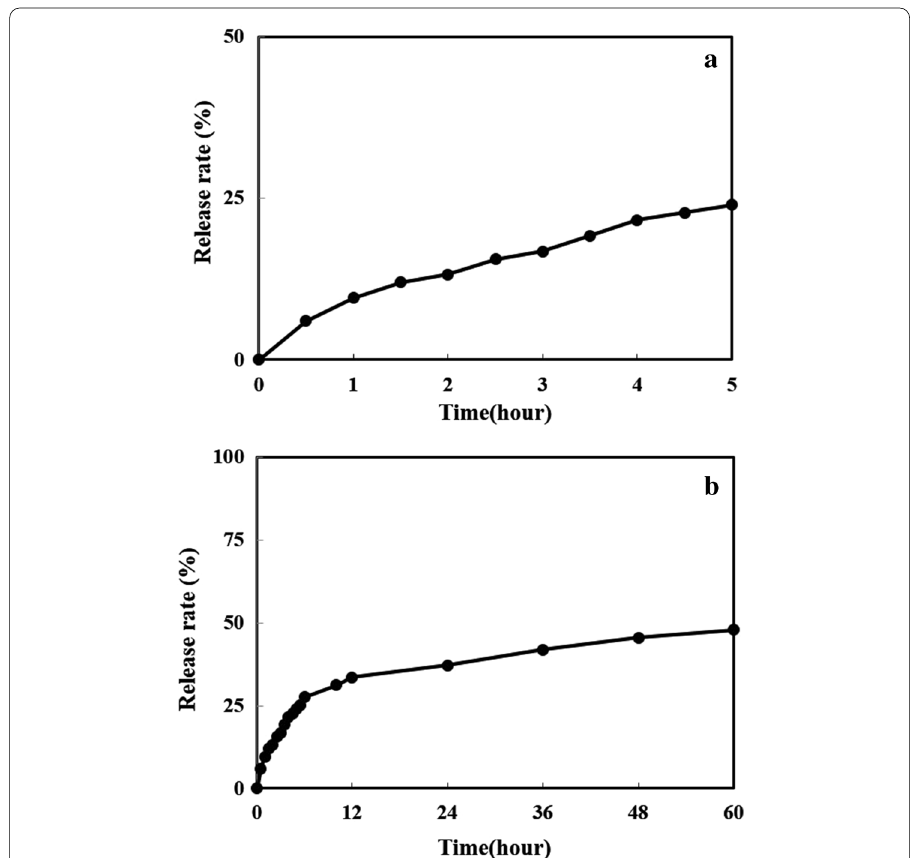
Fig. 8 Release of basil oil in the chitosan microcapsules dissolving acidic sweat solution by over time ( a ) in 5 h, ( b ) in 60